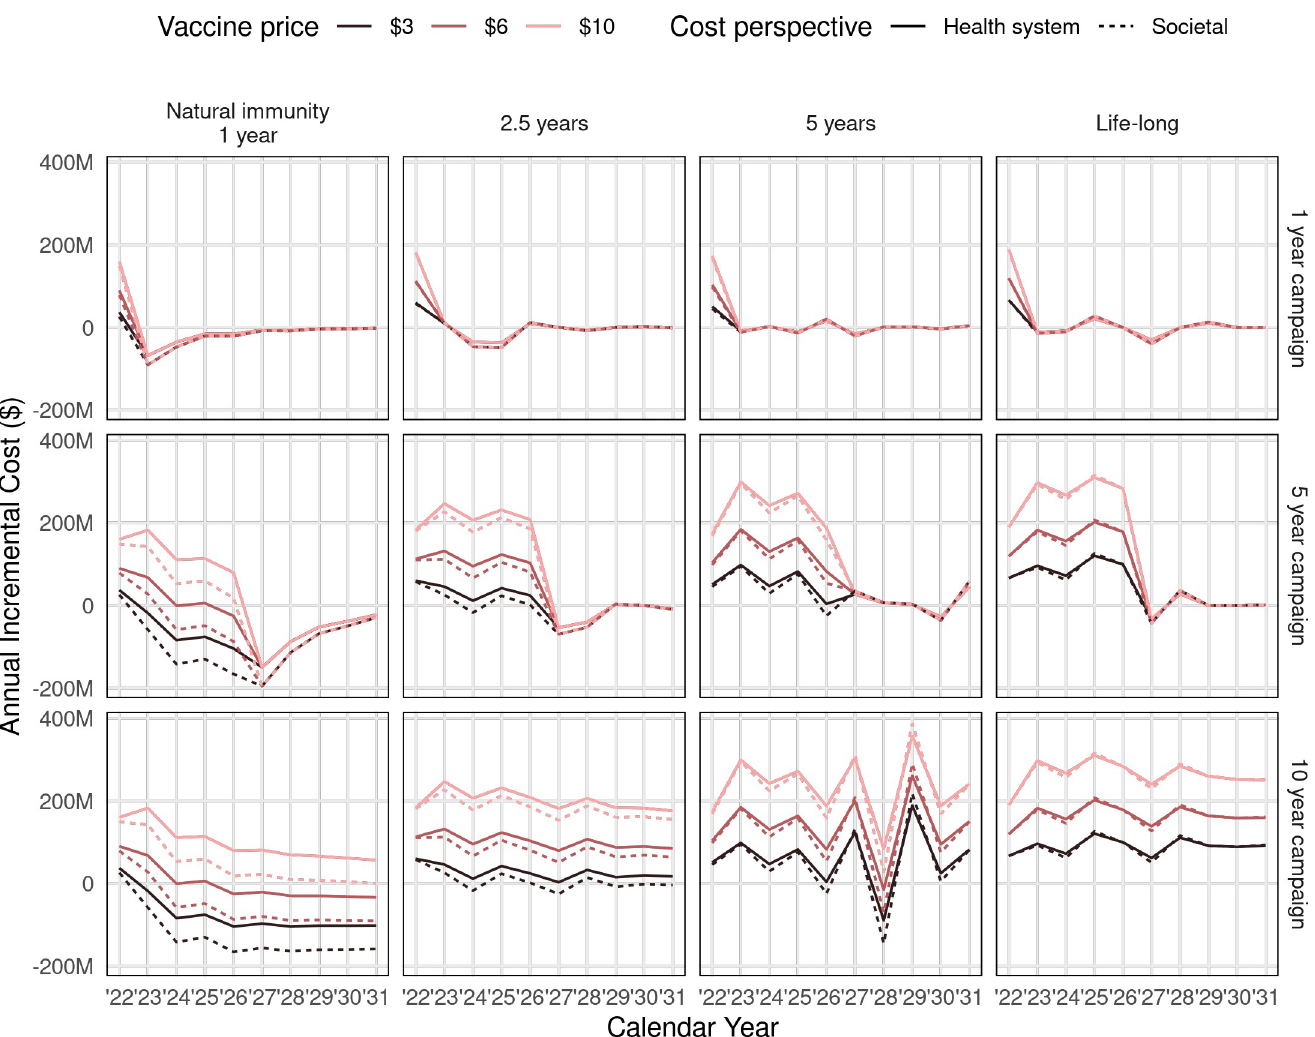
Fig 4. Annual incremental costs of vaccination programme (compared to no vaccination) for different vaccination strategies and assumptions about the duration of infection-induced immunity. Results are shown for vaccination using a 2-dose vaccine regimen with 70% efficacy and 2.5-year duration. The societal perspective includes household out-of-pocket payments and lost income but excludes wider economic impacts of the pandemic. Red lines show different vaccine prices, and the solid and dashed lines show health system costs and with societal costs, respectively.